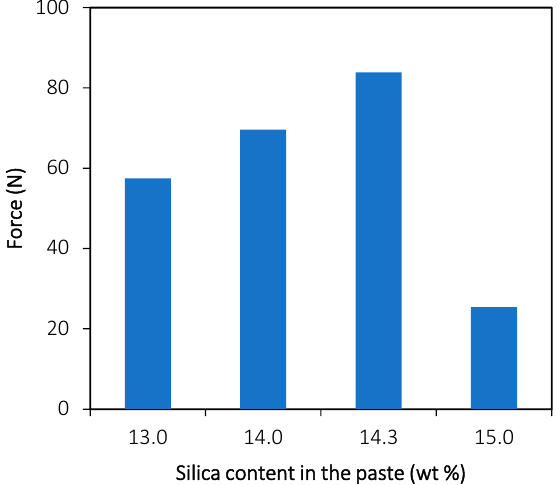
Figure 3. Maximum force applied on ZSM-5 extrudates versus silica content in the extruded paste.